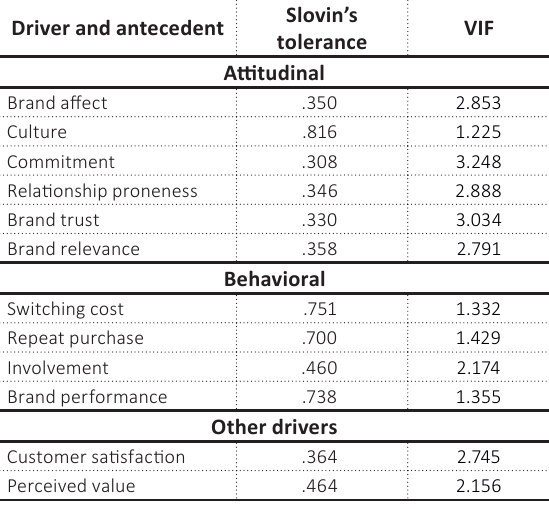
Table 2. Multicollinearity of